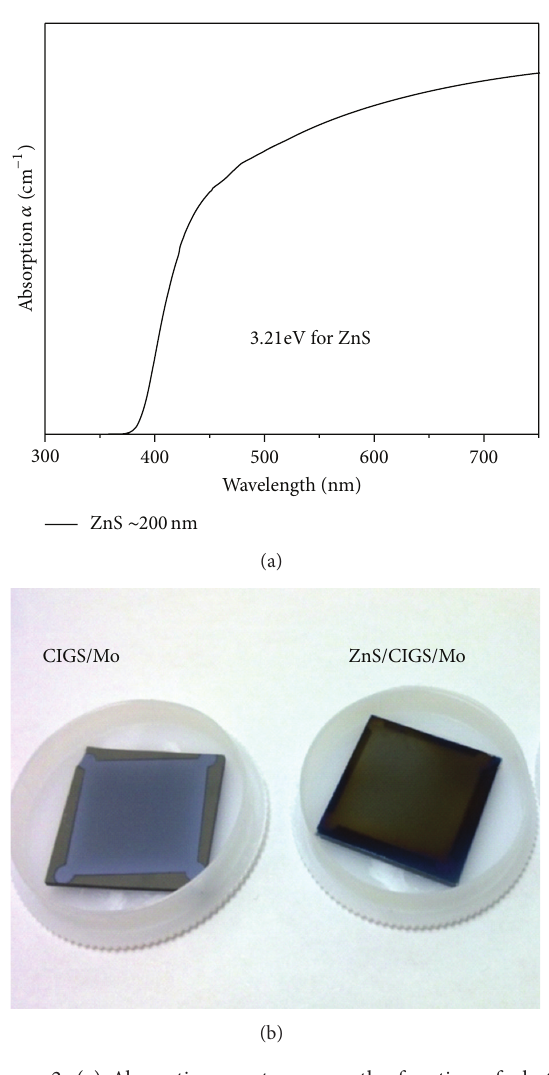
Figure 2: (a) Absorption spectra are as the function of photon energy for the 200 nm ZnS film. (b) Realized sample of ZnS film deposited on CIGS/Mo substrate.